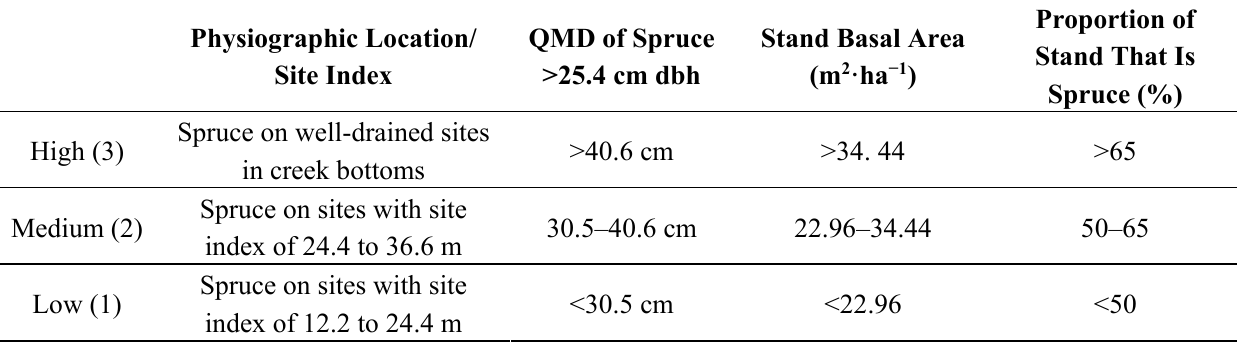
Table 2. Risk rating system developed by Schmid and Frye